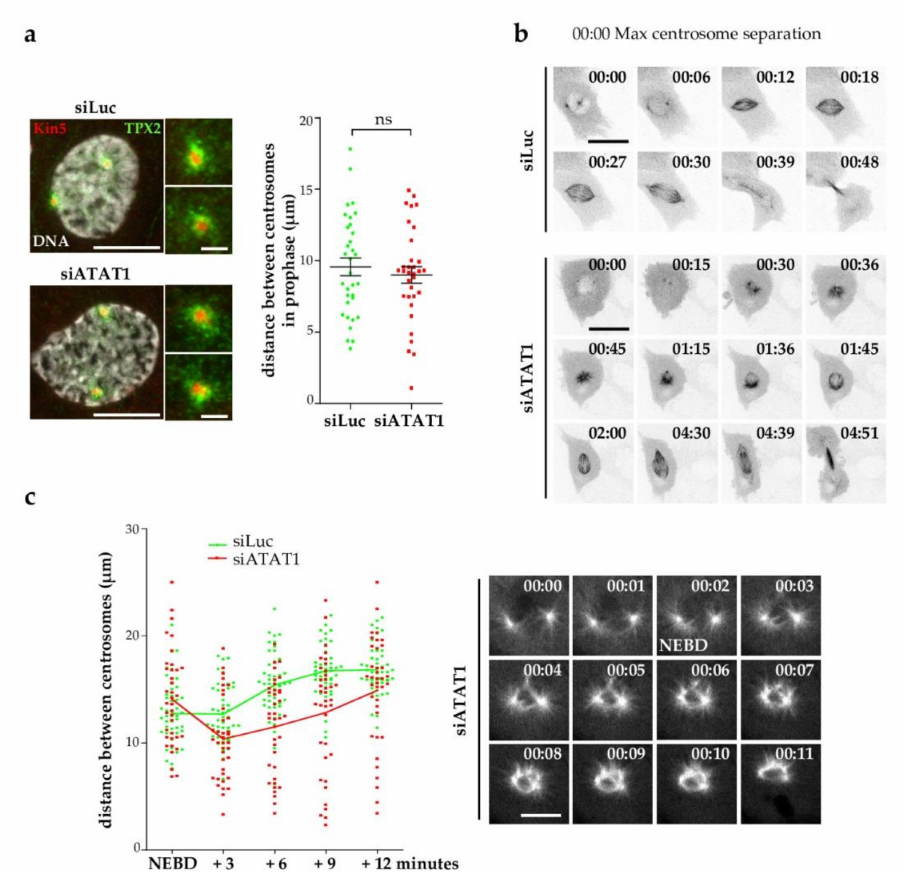
Figure 2. Kinesin-5 dependent centrosome separation is not affected in si ATAT1 cells. LLCPK1 ( a ) or GFP-tubulin-expressing LLCPK1 cells ( b , c ) were transfected for 48 h with siRNAs directed against luciferase (Luc) or ATAT1 . ( a ) Representative MIP images of siLuc and si ATAT1 prophase cells stained for kinesin-5, TPX2 , and DAPI. Scale bar is 10 µ m. Insets show detailed areas of both centrosomes (scale bar is 2.5 µ m). Distances between the two centrosomes were measured, in both conditions, on 3D stacks using Imaris software. Around 10 prophases were counted per condition and per experiment ( n = 3). ( b ) Live cells were imaged every 3 min using a dragonfly ANDOR spinning disk confocal microscope. Scale bar is 25 µ m. ( c ) Left panel, quantification of the evolution of the distance between the two centrosomes in a 12-min time range after nuclear envelop breakdown (NEBD). Distances were measured as in ( a ) ( n = 3, in total 49 siLuc, and 37 si ATAT1 cells were analyzed). Solid lines show the mean of the distances. Right panel, representative images, acquired every min, of an si ATAT1 GFP-tubulin-expressing LLCPK1 cell entering mitosis. Scale bar is 10 µ